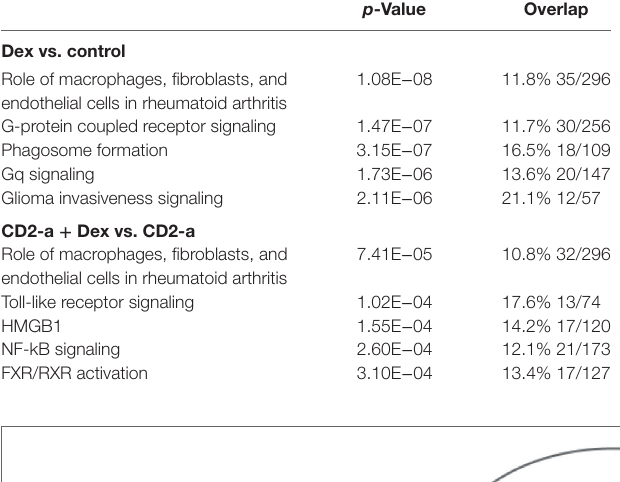
p -Value Overlap